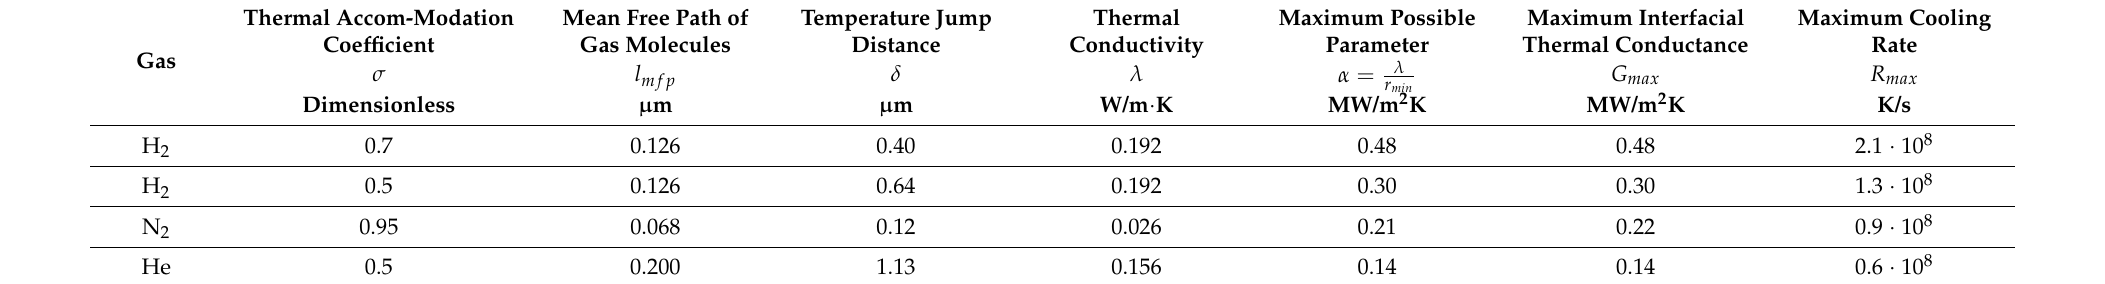
Table 2. Thermal and contact parameters of gases for a bright membrane at 300 K and 10 5 Pa.